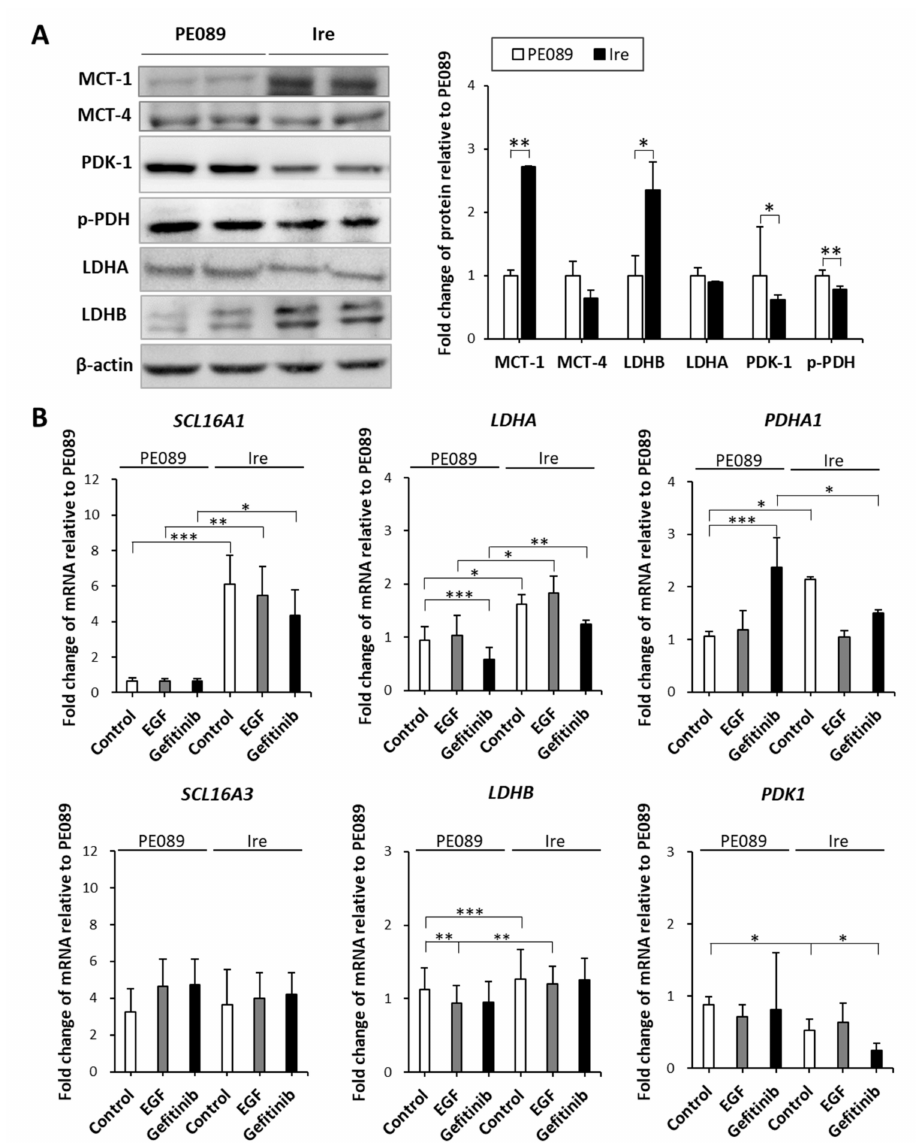
Figure 6. Di ff erential expression levels of OXPHOS-related regulators in PE089 and Ire cells. ( A ) Representative immunoblots for MCT-1, MCT-4, PDK-1, p-PDH E1 α , LDHA and LDHB are shown. β -Actin was used as a loading control. Significantly higher levels of MCT-1 and LDHB and decreased levels of PDK-1 and p-PDH were found in Ire cells. ( B ) The di ff erential expression levels of SCL16A1 (encodes MCT-1), SCL16A3 (encodes MCT-4), LDHA , LDHB , PDHA1 and PDK1 mRNA were determined by real-time qPCR. The expression levels were normalized to an internal control ( ACTB ) and fold changes were relative to the control. The values represent the mean ± S.D. from three independent experiments and each experiment performed in duplicate. * p < 0.05. ** p < 0.01. *** p <